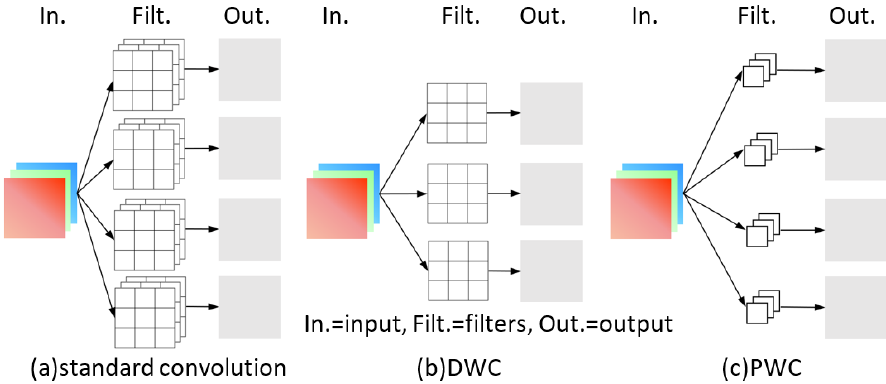
Figure 2. Comparison of convolution